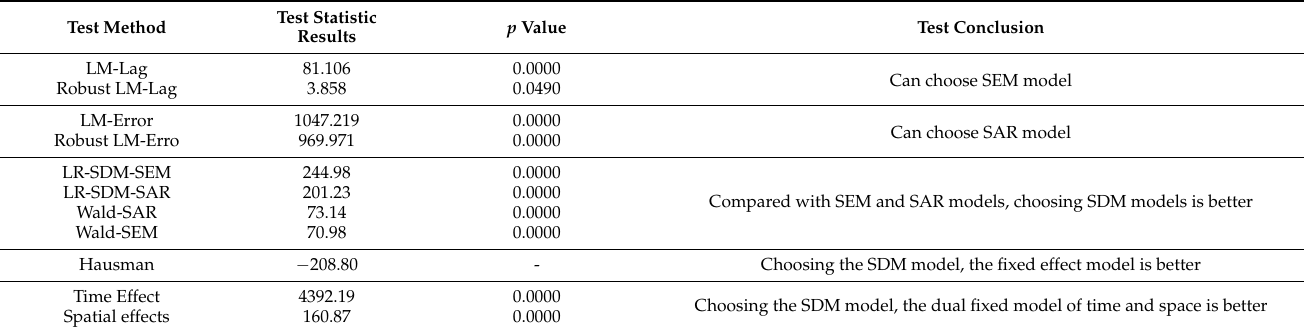
Table 4. Test results of model settings